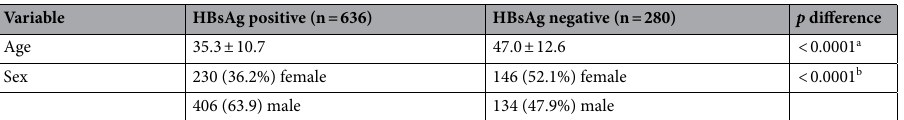
Table 1. Summary statistics for patient demographics, Nigeria, 2010–2020. HBsAg hepatitis B surface antigen. a Two sample t-test, b Chi-square test.